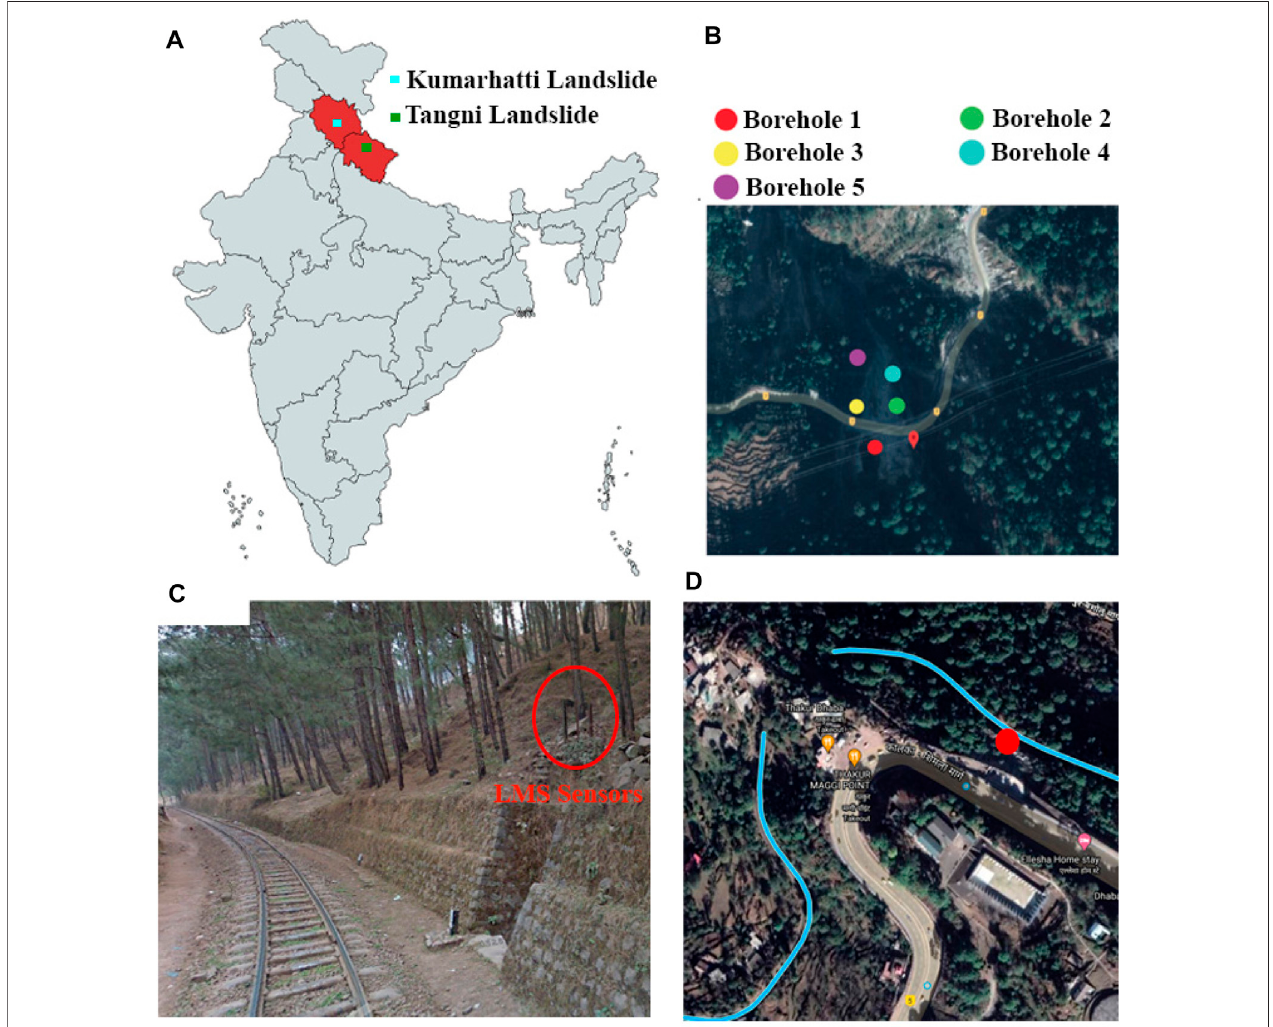
FIGURE 1 | (A) Locations of the study areas. (B) Borehole location of the Tangni site on Google Maps. (C) The landslide monitoring sensors installed on a hill near the railway track at Kumarhatti. (D) The Kumarhatti site ’ s location on Google Maps.